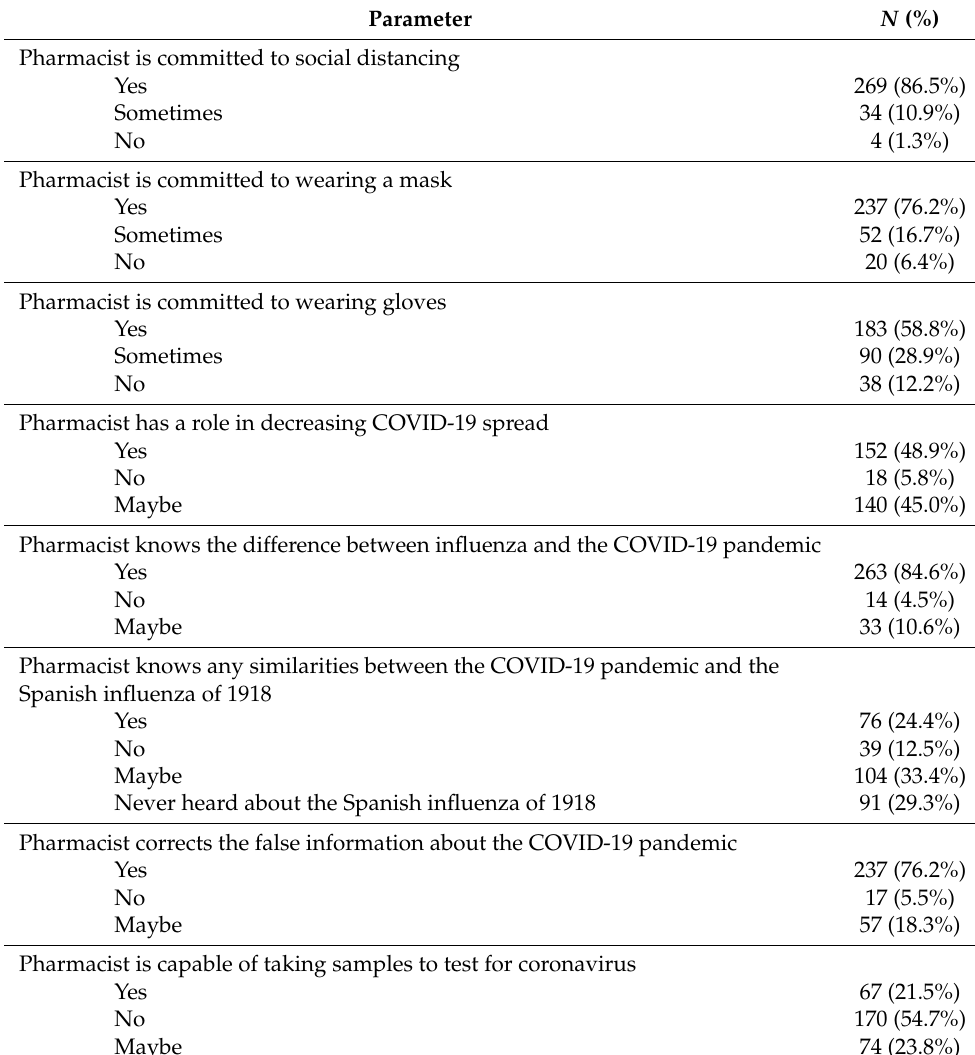
Table 2. Pharmacists’ knowledge, attitudes, and practices during the COVID-19 pandemic, ( N =